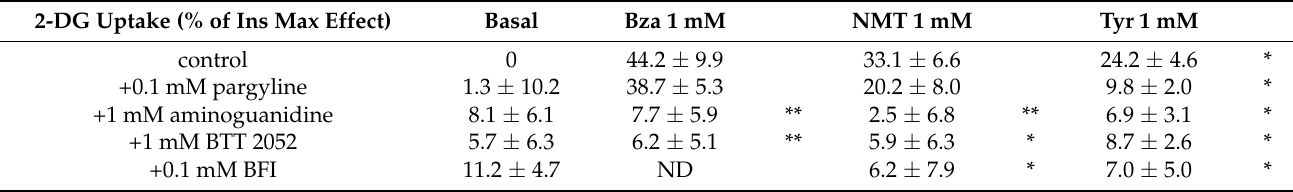
Table 1. Sensitivity of the amine-induced hexose transport to amine oxidase inhibitors in freshly isolated human